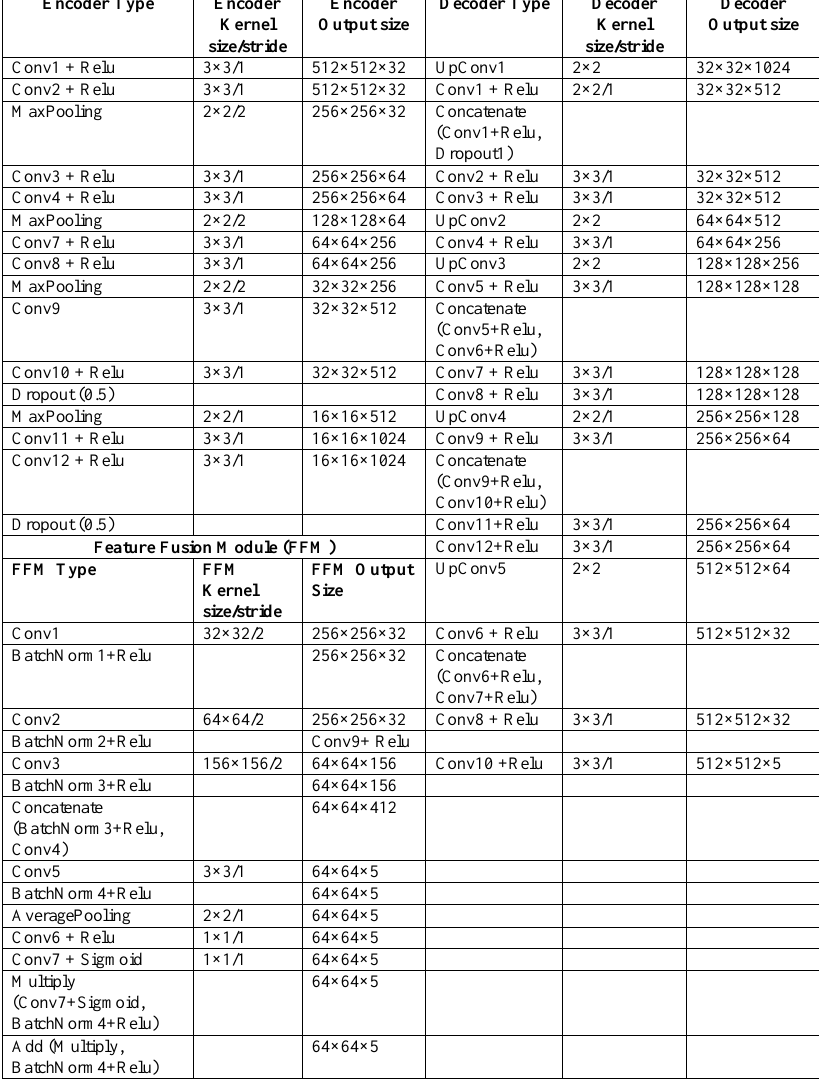
Figure 2. Architecture of